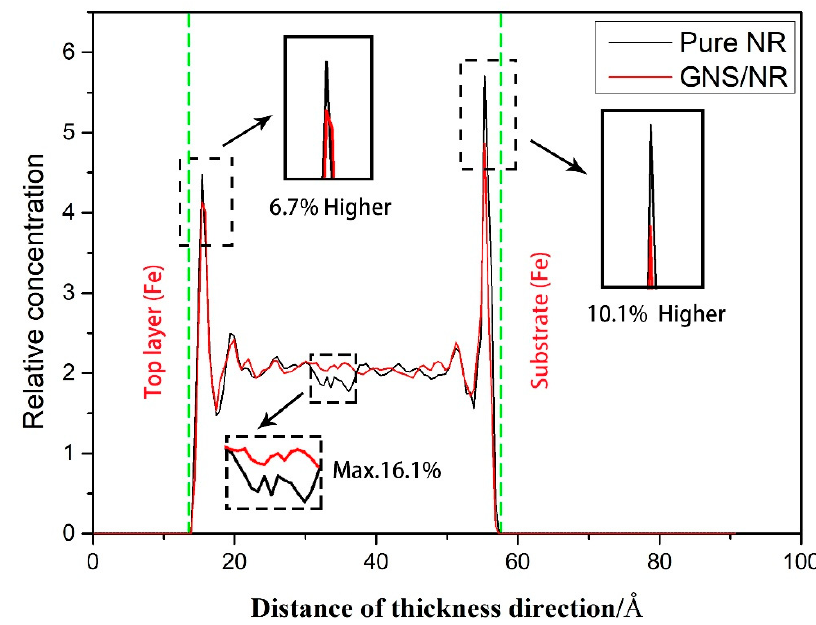
Figure 10. Relative atomic concentration distribution along the thickness direction of the pure NR and GNS/NR composites.